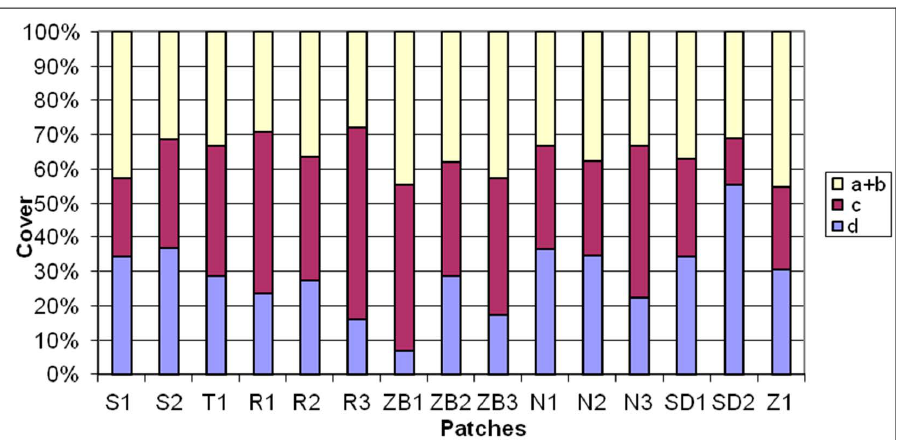
Figure 2. Number of plant species in the patches.